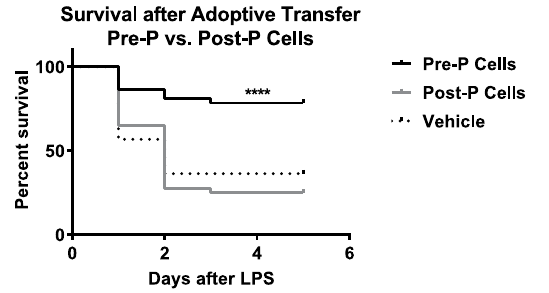
Figure 7. Adoptive transfer of pre-pubertal cells improves post-pubertal survival. Naïve peritoneal cells were collected from pre-pubertal mice or post-pubertal mice by peritoneal lavage. Recipient post-pubertal mice were administered 1 mL of pre-pubertal (Pre-P) or post-pubertal (Post-P) peritoneal cell suspensions (2 million cells total), or 1 mL of the vehicle (PBS) via intraperitoneal injection. Following incubation of donor cells within the peritoneal cavity, the recipient mice were then subjected to endotoxemia with either S. enterica or E. coli endotoxin (N ≥ 37/group). Per cent survival was recorded over five days. Significant differences in survival between mice administered Pre-P cells vs. those receiving Post-P cells or Vehicle were **** (p < 0.0001). Per cent survival was compared using a log rank Mantel Cox